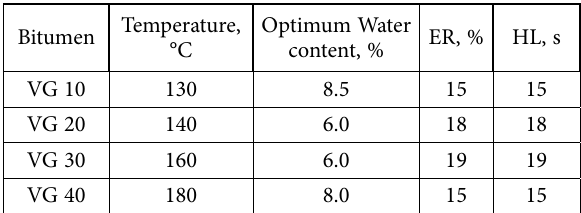
Table 3. Optimum Expansion Ratio and Half Life of different